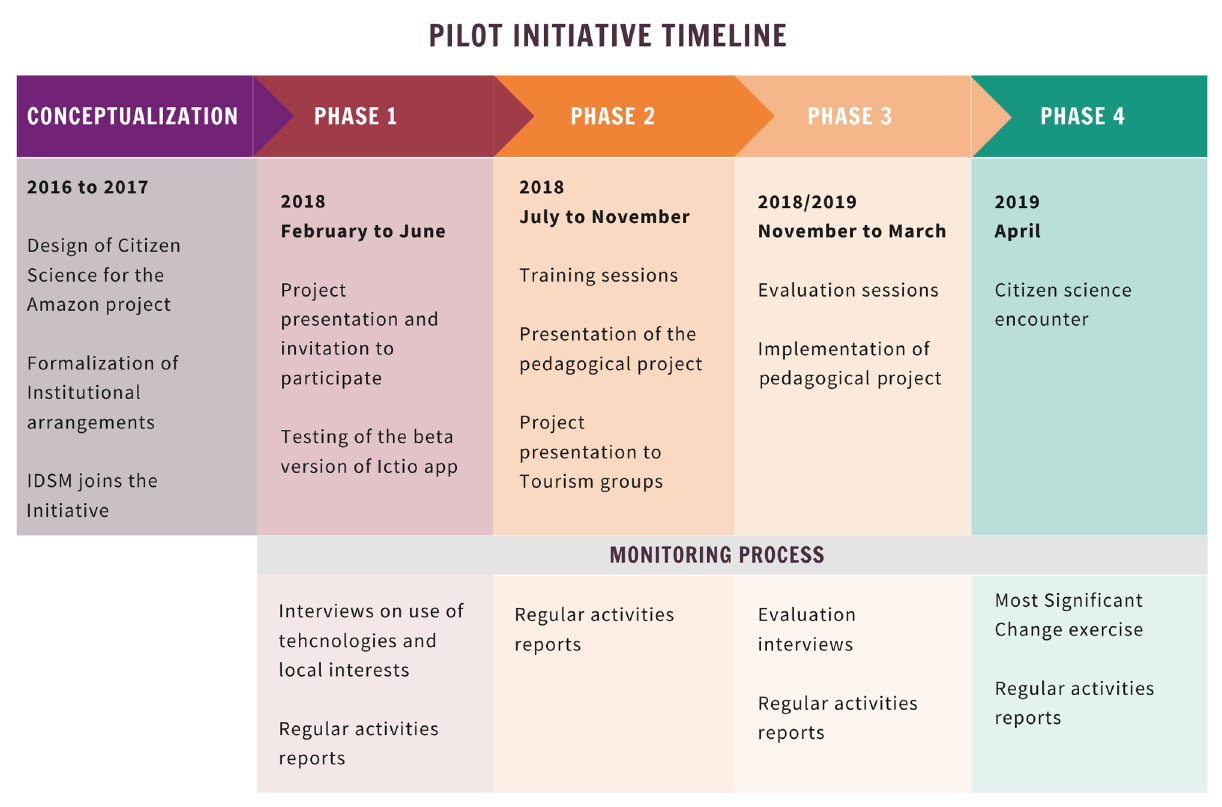
Figure 1 Timeline of the pilot initiative and monitoring process. Most Significant Change: